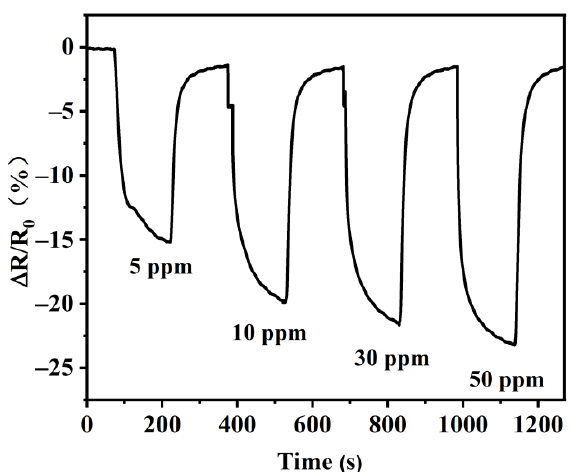
Figure 10. Response and recovery curves of the MoS 2 /rGO/GQDs-2 sensor towards different concentrations of NO 2 .